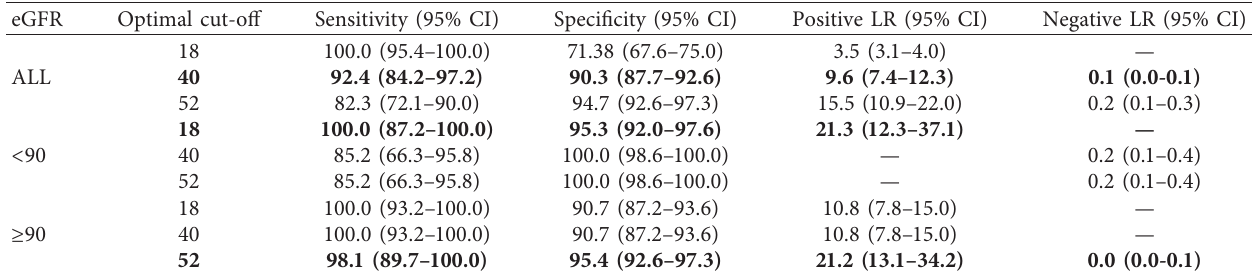
Figure 2: Receiver operating characteristic curves according to eGFR. Evaluation of ARR accuracy for the screening for PA using ROC curve analysis in the full study cohort (a), in those with eGFR < 90ml/min/1.73 m 2 (b), and in those with eGFR ≥ 90ml/min/1.73 m 2 (c). ARR: aldosterone-to-renin ratio; eGFR: estimated glomerular filtration rate; PA: primary aldosteronism; ROC: receiver operating char- acteristic curves. Table 2: Test characteristics of ARR to screen for PA according to stratified